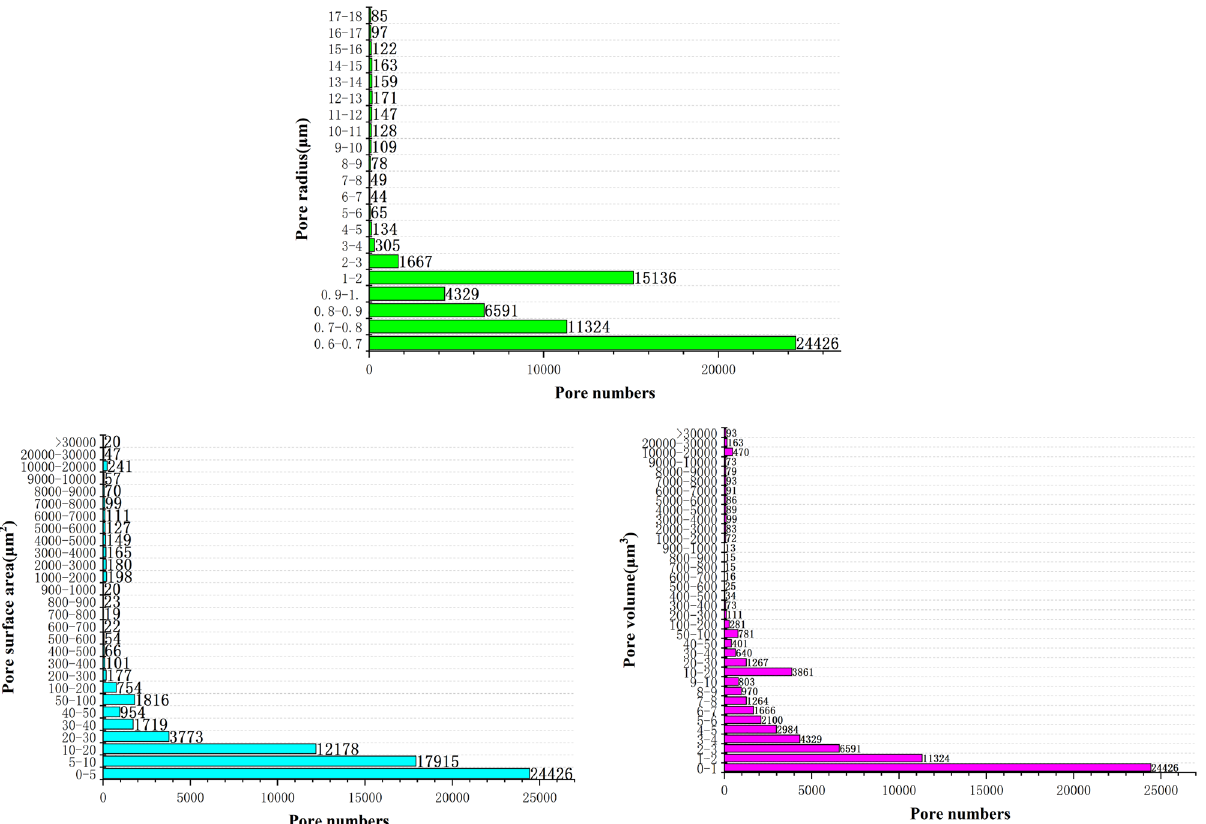
Figure 25. Statistics of pore quantitative parameters of nylon-uncured rubber